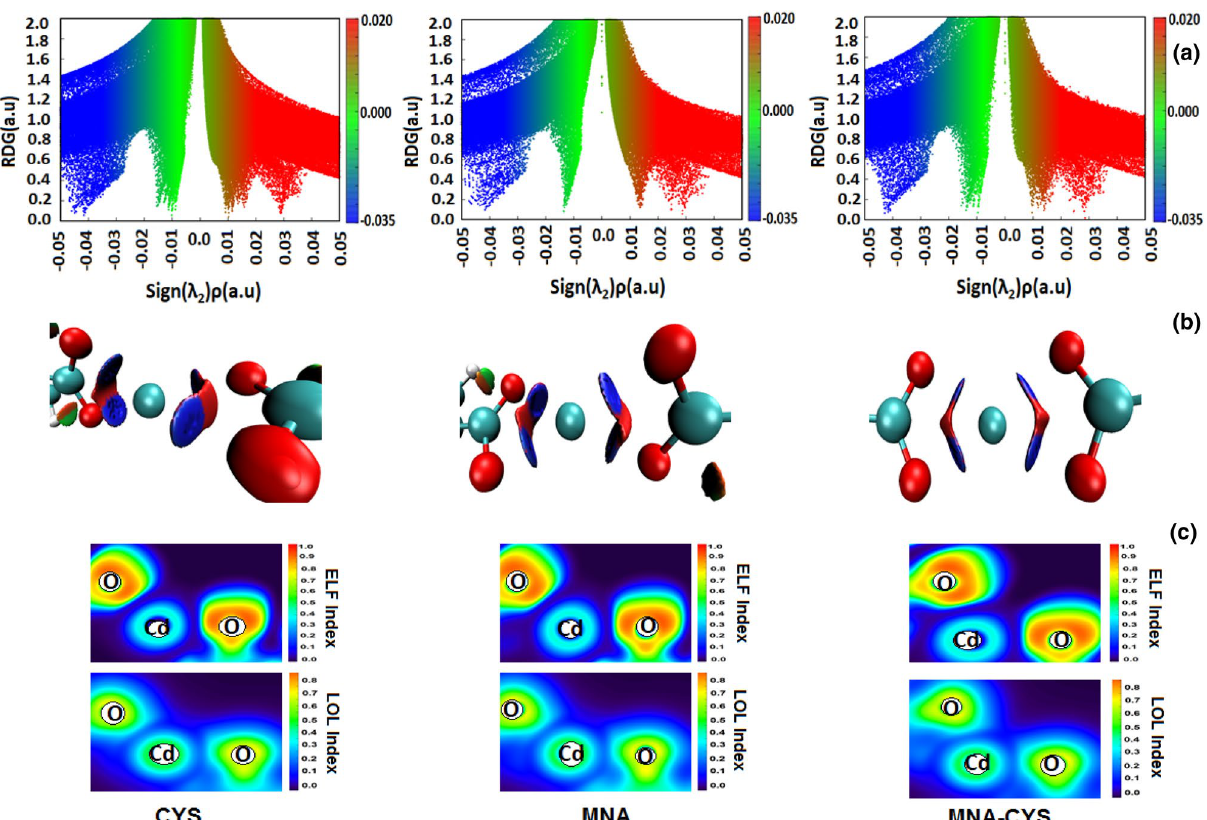
Figure 8. The 2D ( a ) and 3D ( b ) NCI plots and ELF and LOL graphs ( c ) of the Cd 2+ complexes with MNA and CYS